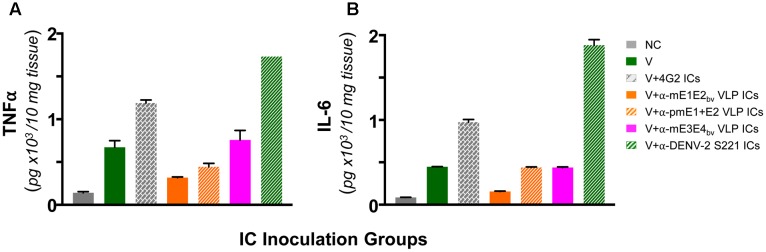
Determination of levels of TNF-α and IL-6 in small intestines of AG129 mice after inoculation of ICs. Groups of AG129 mice (n = 3) were challenged with a sub-lethal dose of DENV-2 S221 (V) or 100% in vitro-neutralized ICs of DENV-2 S221 with mAb 4G2 (V+4G2 ICs), anti-mE1E2bv VLP antiserum (V+α-mE1E2bv VLP ICs), anti-pmE1+E2 VLP antiserum (V+ α-pmE1+E2 VLP ICs), anti-mE3E4bv VLP antiserum (V+α-mE3E4bv VLP ICs), or anti-DENV-2 S221 antiserum (V+ α-DENV-2 S221 ICs), in parallel with the inoculations described in Figure 6B. One group was included as negative control (NC) which did not receive any treatment. Three days post-inoculation mice were euthanized, small intestines dissected out after perfusion and homogenized. Clarified homogenates were used for the determination of TNF-α (A) and IL-6 (B) using commercial ELISA kits, with purified recombinant murine TNF-α and IL-6 as references. Data shown are the mean values with the bars denoting standard deviation (n = 3).